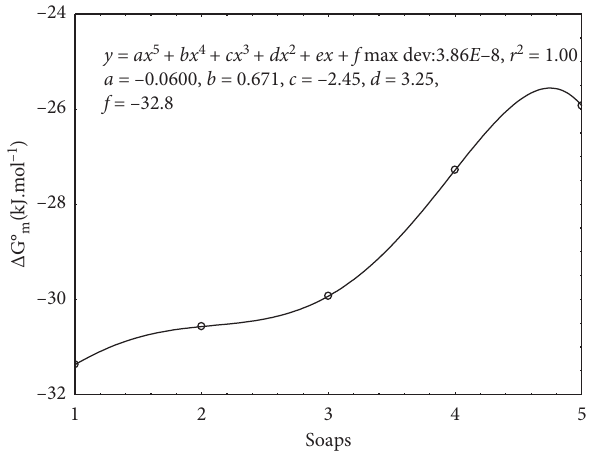
Figure 6: Variation of Δ G o